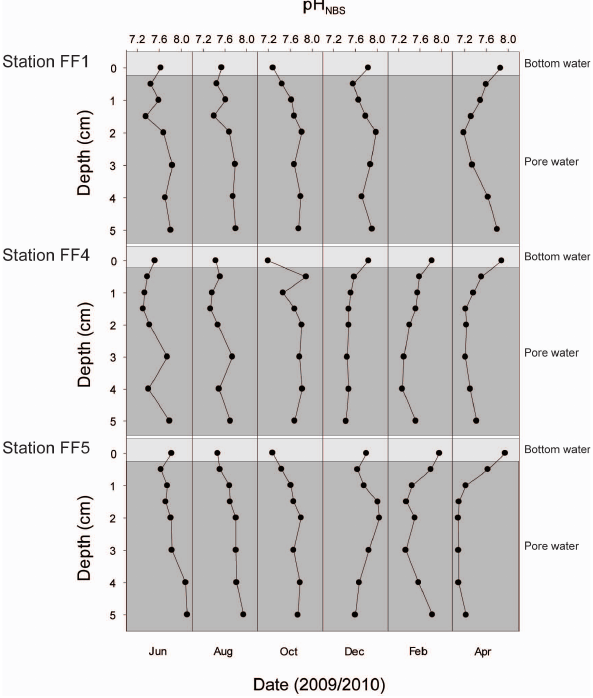
Fig. 3. Bottom and sediment pore water profiles of pH NBS plotted vs. sediment depth (cm) at stations FF1, FF4 and FF5 during the seasonal cycle